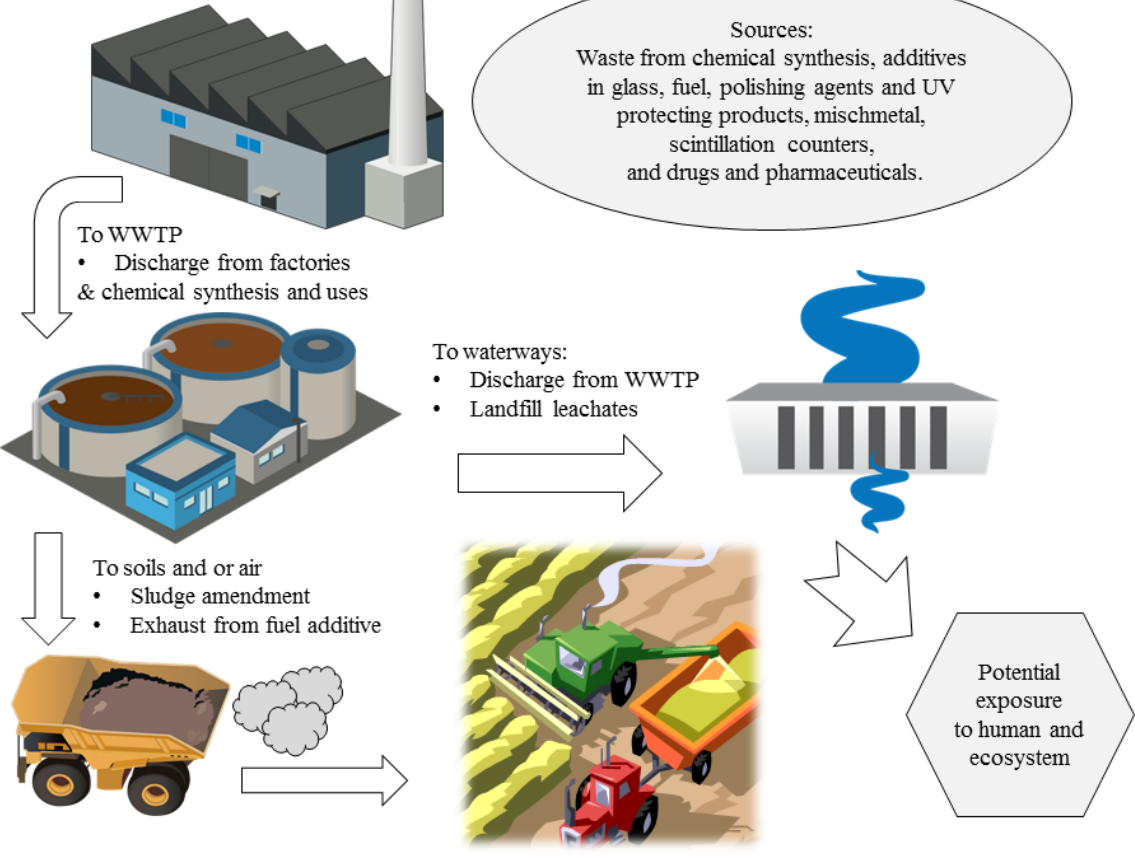
Figure 1. Environmental fate of cerium based consumer and industrial products including CeO nanoparticles. Illustrations of water treatment plant, factory and water discharge are 2 from integration and application network,